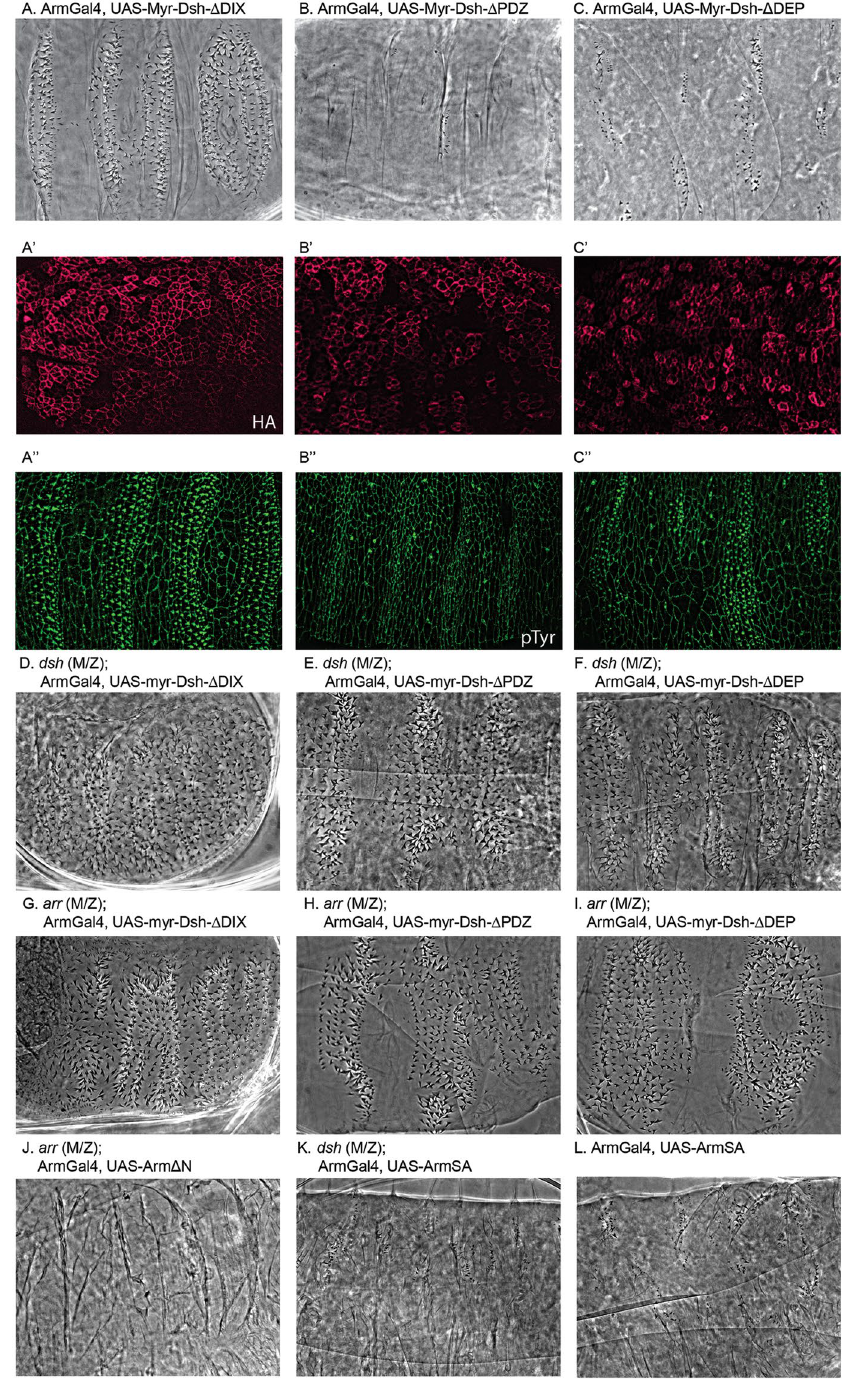
Figure 5. Cuticle of ( A ) Myr-Dsh Δ DIX expressed in ‘wild type’ embryos, producing more ectopic denticles due to signaling inactivation. ( B , C ) Cuticles of Myr-Dsh Δ PDZ and Myr-Dsh Δ DEP expressing embryos, showing a naked phenotype (GOF). Staining for ectopic tag HA and denticle precursors (pTyr) in wild type embryos expressing Myr-Dsh Δ DIX (A’-A”), Myr-Dsh Δ PDZ (B’-B”) and Myr-Dsh Δ DEP (C’-C”). D–F ) Myr-Dsh Δ PDZ ( E ) and Myr-Dsh Δ DEP ( F ) expression in dsh (M/Z) mutant embryos rescued Wnt signaling whereas expressing Myr-Dsh Δ DIX ( D ) in dsh (M/Z) mutant embryos did not. ( G ) Arrow null embryo expressing Myr-Dsh Δ DIX showing no activation of signaling and hence the wingless phenotype. ( H – I ) Arrow null mutant suppressed by expression of Myr-Dsh Δ PDZ and Myr-Dsh Δ DEP suggesting requirement for a membrane recruitment. Cuticle of arr (M/Z) ( J ), dsh (M/Z) ( K ) and wildtype ( L ) embryos expressing activated Arm alleles either lacking the N-terminus (Arm Δ N) or a specific ArmS56A substitution (ArmSA) both of which block phosphorylation and degradation of Arm. Expression in these backgrounds led to loss of denticles, reflecting constitutive activation of Wg